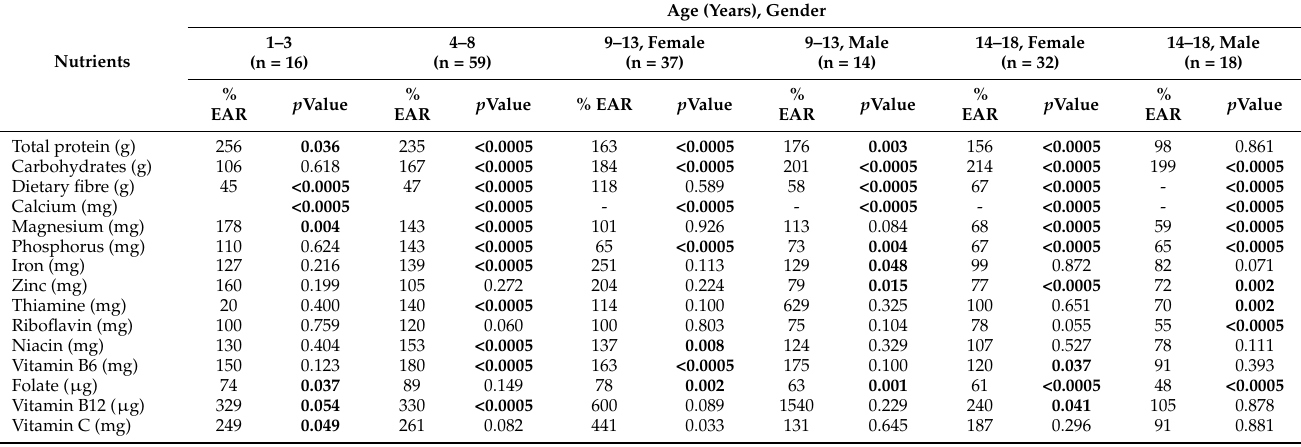
Table 5. Percentage of EAR met from the two 24 h repeated recalls for individuals aged 1–70